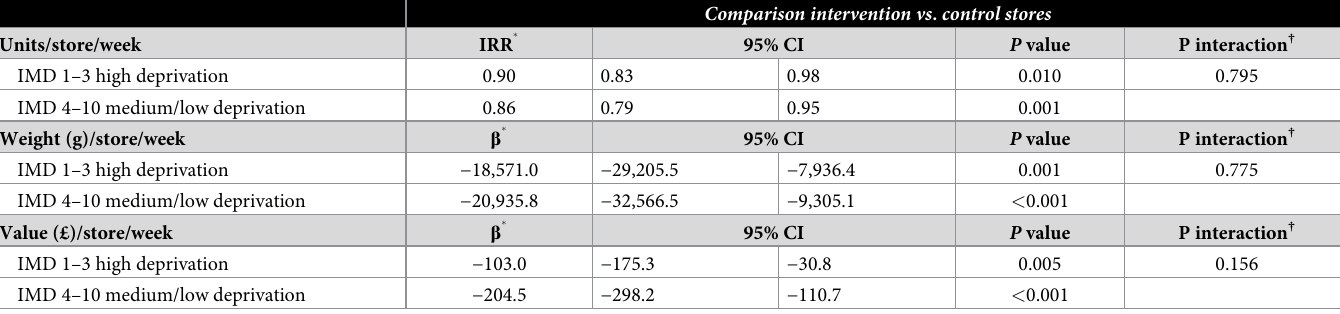
� IRRs from hierarchical negative binomial models (used in the models of unit sales), with fixed effect adjustment for store ethnicity, IMD, and average sales per week over the 2018 period; Beta ( β ) coefficients from hierarchical normal mixed models (used in the models of gr and £ sales), with fixed effect adjustment for store ethnicity, IMD, and average sales per week over the 2018